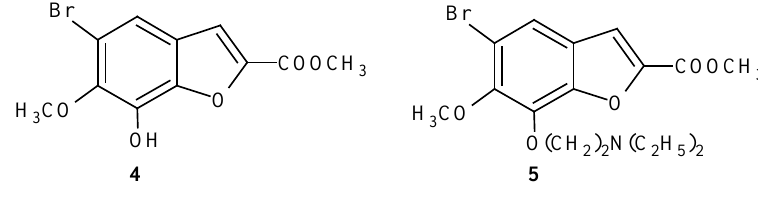
Figure 3. The structures of methyl 5-bromo-7-hydroxy-6-methoxy-1-benzofuran-2- carboxylate ( 4 ); methyl 5-bromo-7-[2-(diethylamino)ethoxy]-6-methoxy-1-benzofuran-2- carboxylate ( 5 ).